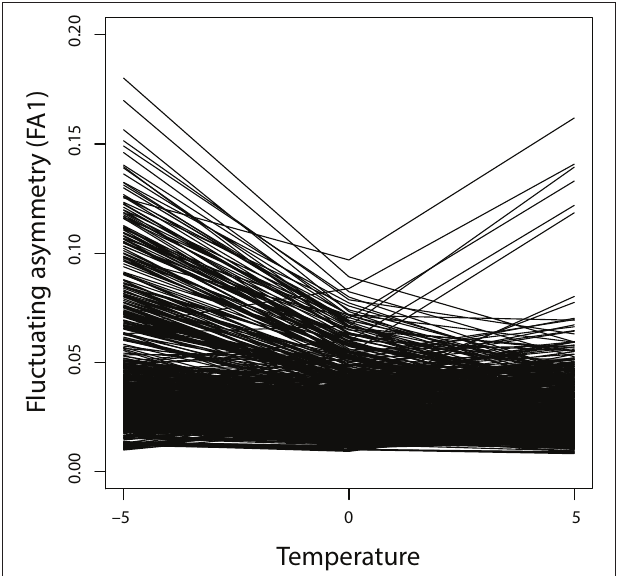
FIGURE 5 | Reaction norms for fluctuating asymmetry. For each of the 729 possible genotypes, the lines connect the values of the FA1 index for the cold, reference and warm temperatures (with the reference temperature designated zero).